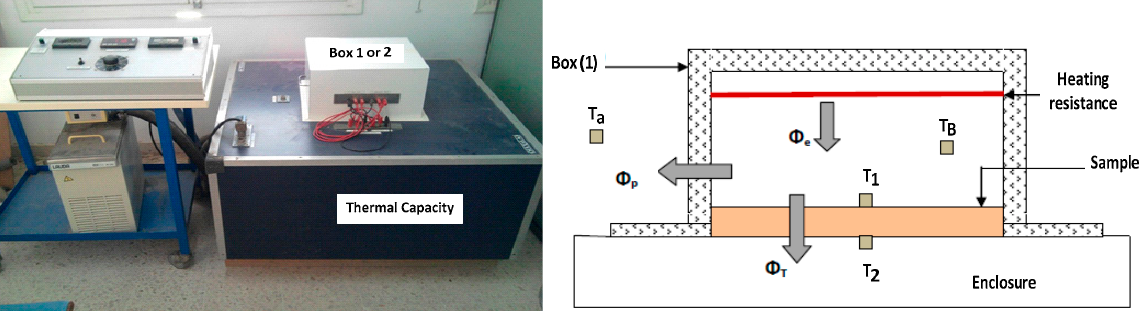
Figure 6. Thermal conductivity testing device.